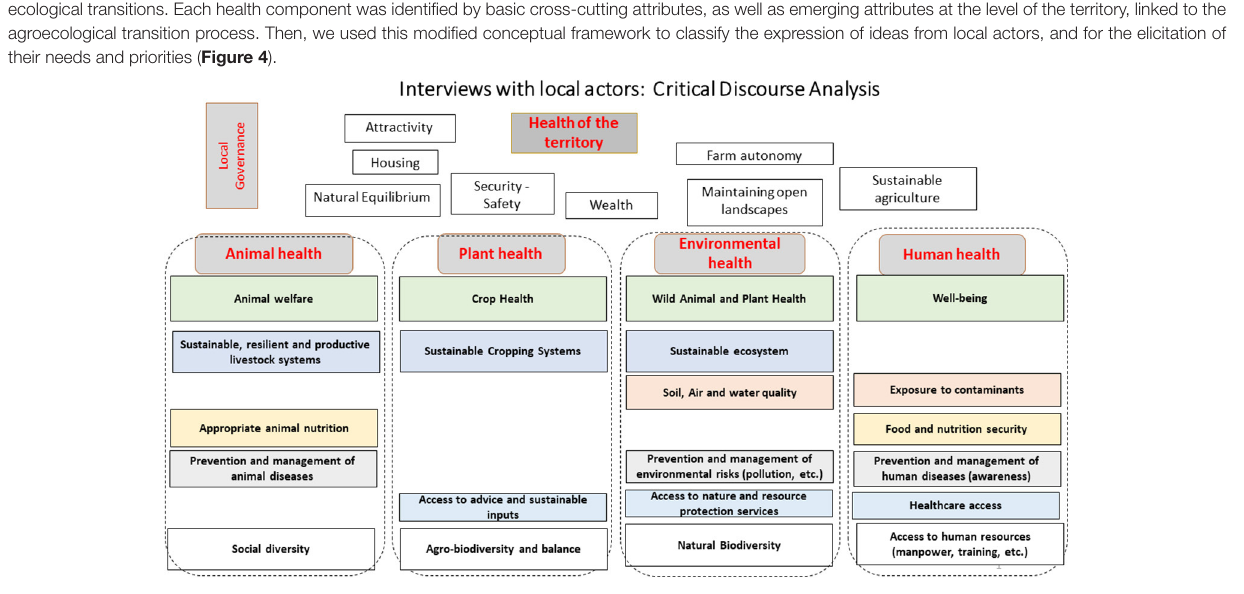
Frontiers in Public Health |